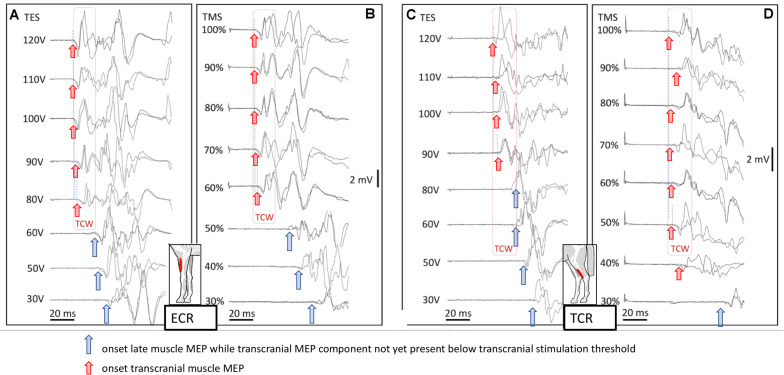
Landscape plots of muscle mMEPs of the m. ECR (A,B) and m. TC (C,D) at TES (A,C) and TMS (B,D). TS thresholds: ET = 80 V (ECR) and 90 V (TC); MT = 60% (ECR) and 50% (TC). The TCW are indicated by the dashed box contour lines. The up-pointing arrows indicate the onset of transcranial or extracranial late mMEPs as described by the legend in the figure.